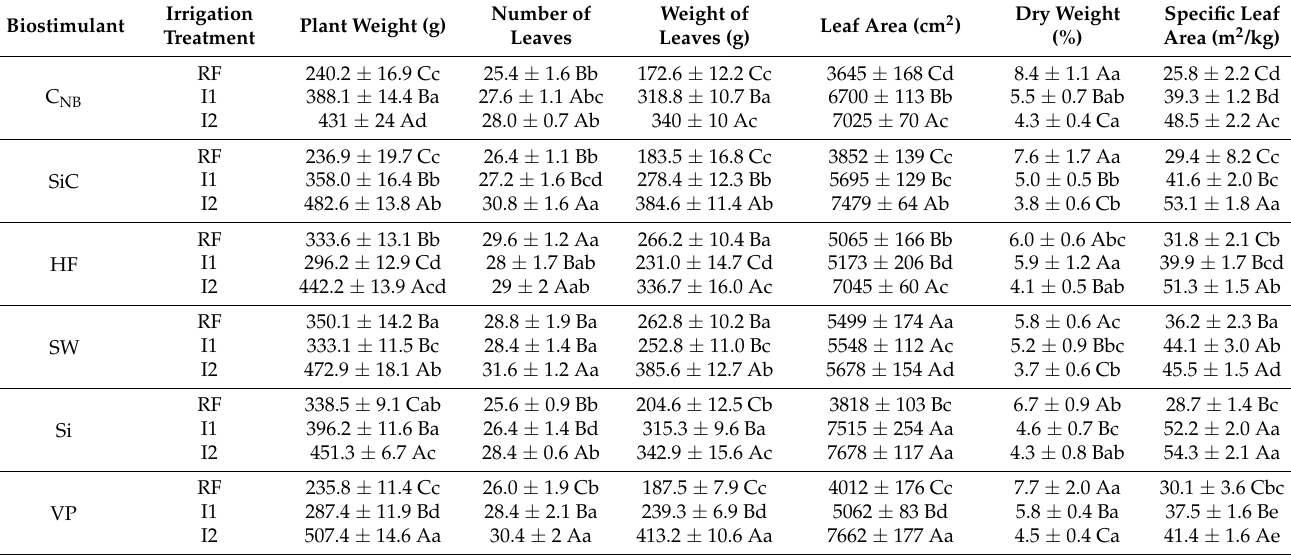
Table 4. Growth parameters of Batavia-type lettuce plants concerning the irrigation regime and the biostimulant treatment (means ±